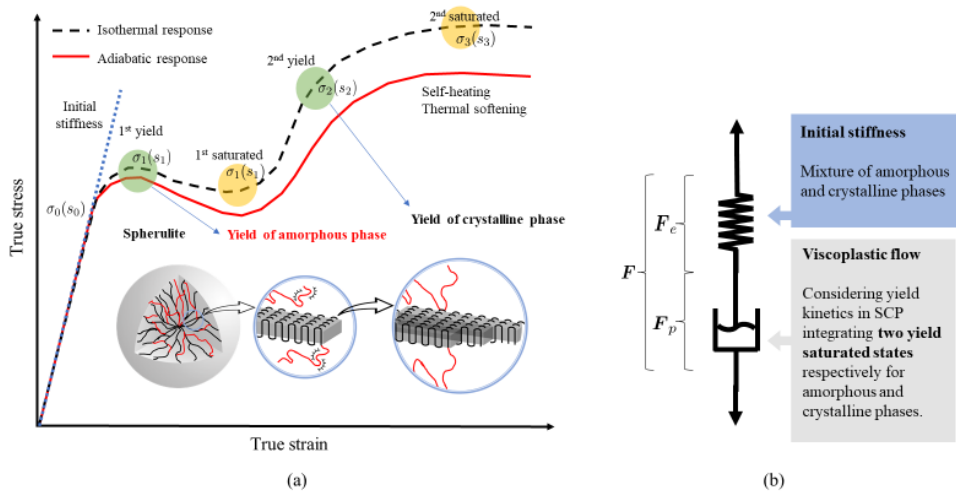
Figure 2. Schematic diagram of the morphological transformation of molecular structure in SCP with ( a ) corresponding stress-strain curve and ( b ) rheological representation.